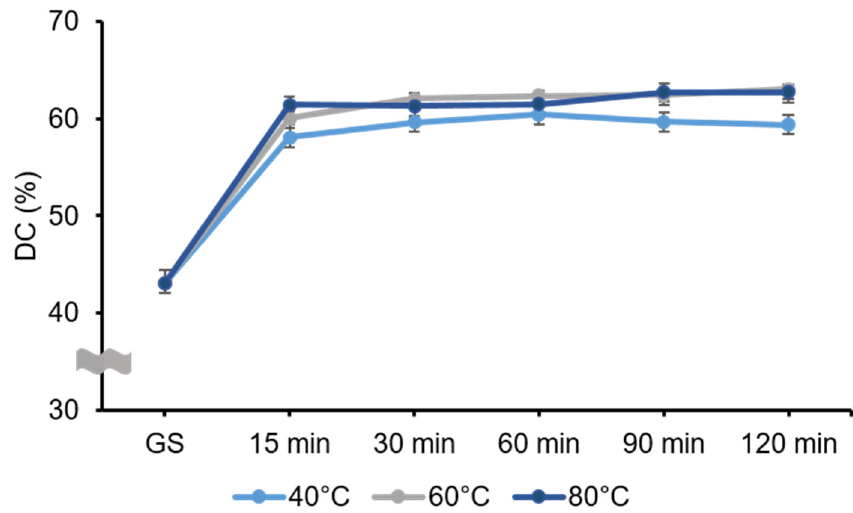
Figure 9. Degree of conversion (DC) of the 3D printed resin specimens that were postcured under different postcuring conditions. DC gradually increased after 15 min of postcuring for all temperatures. Data are mean and standard-deviation values.